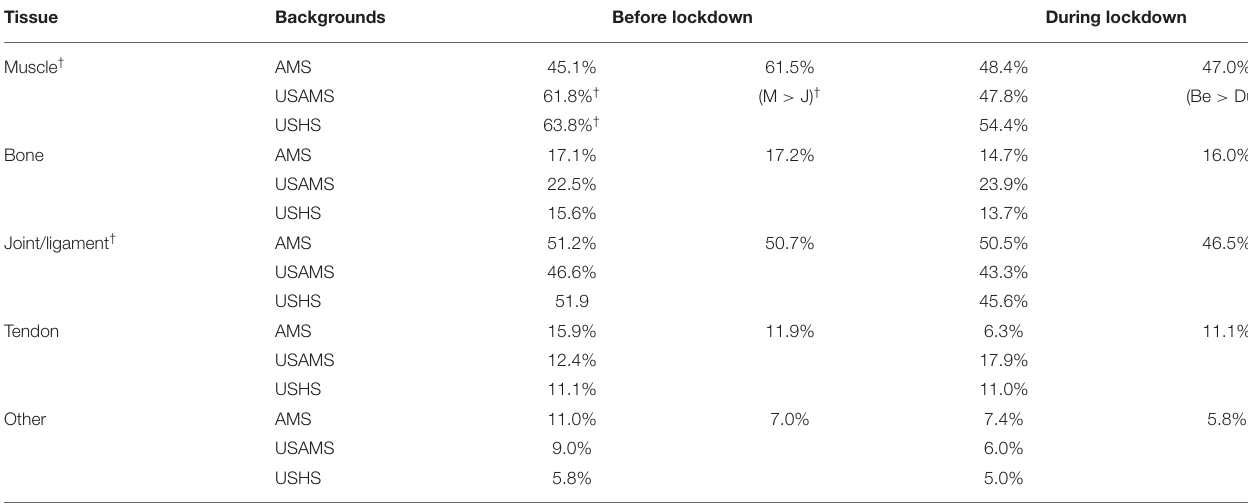
TABLE 4 | Tissue injury in two periods